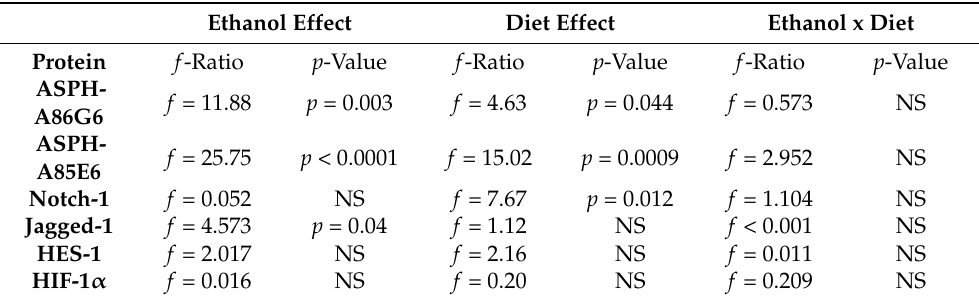
Table 5. Ethanol and Dietary Protein Effects on ASPH and Notch Pathway